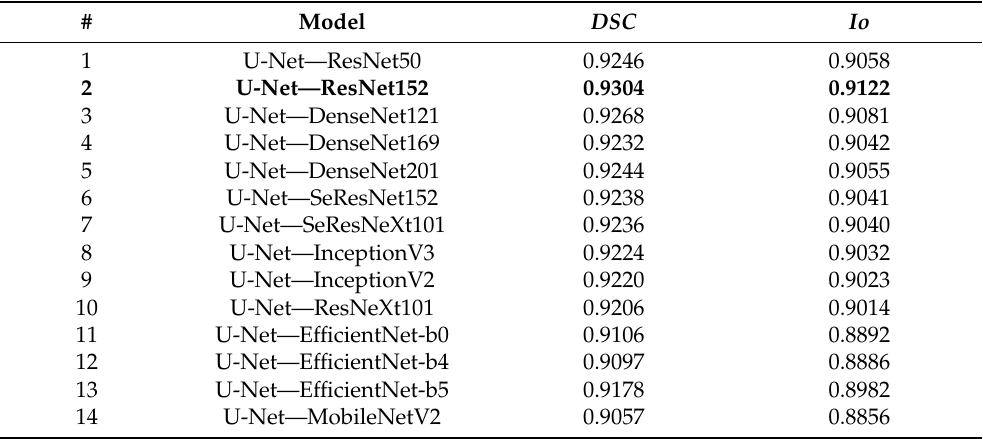
Table 2. Summary table of the test metrics DSC and IoU for models of different architectures.